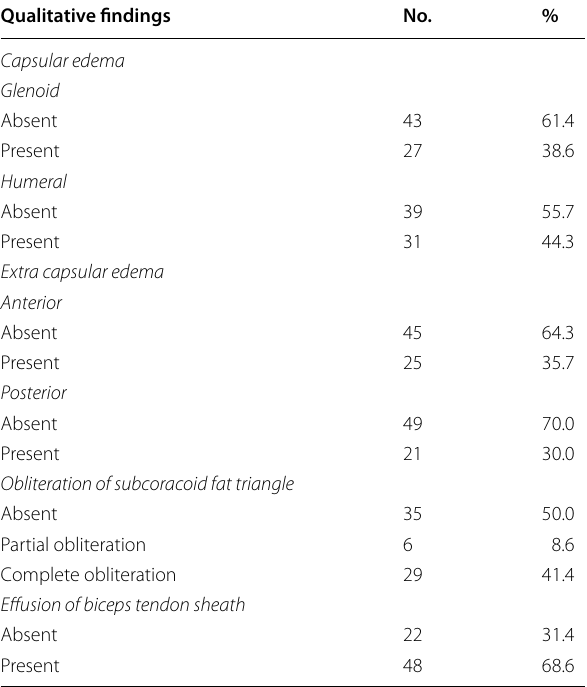
Table 3 Qualitative findings distribution among study group